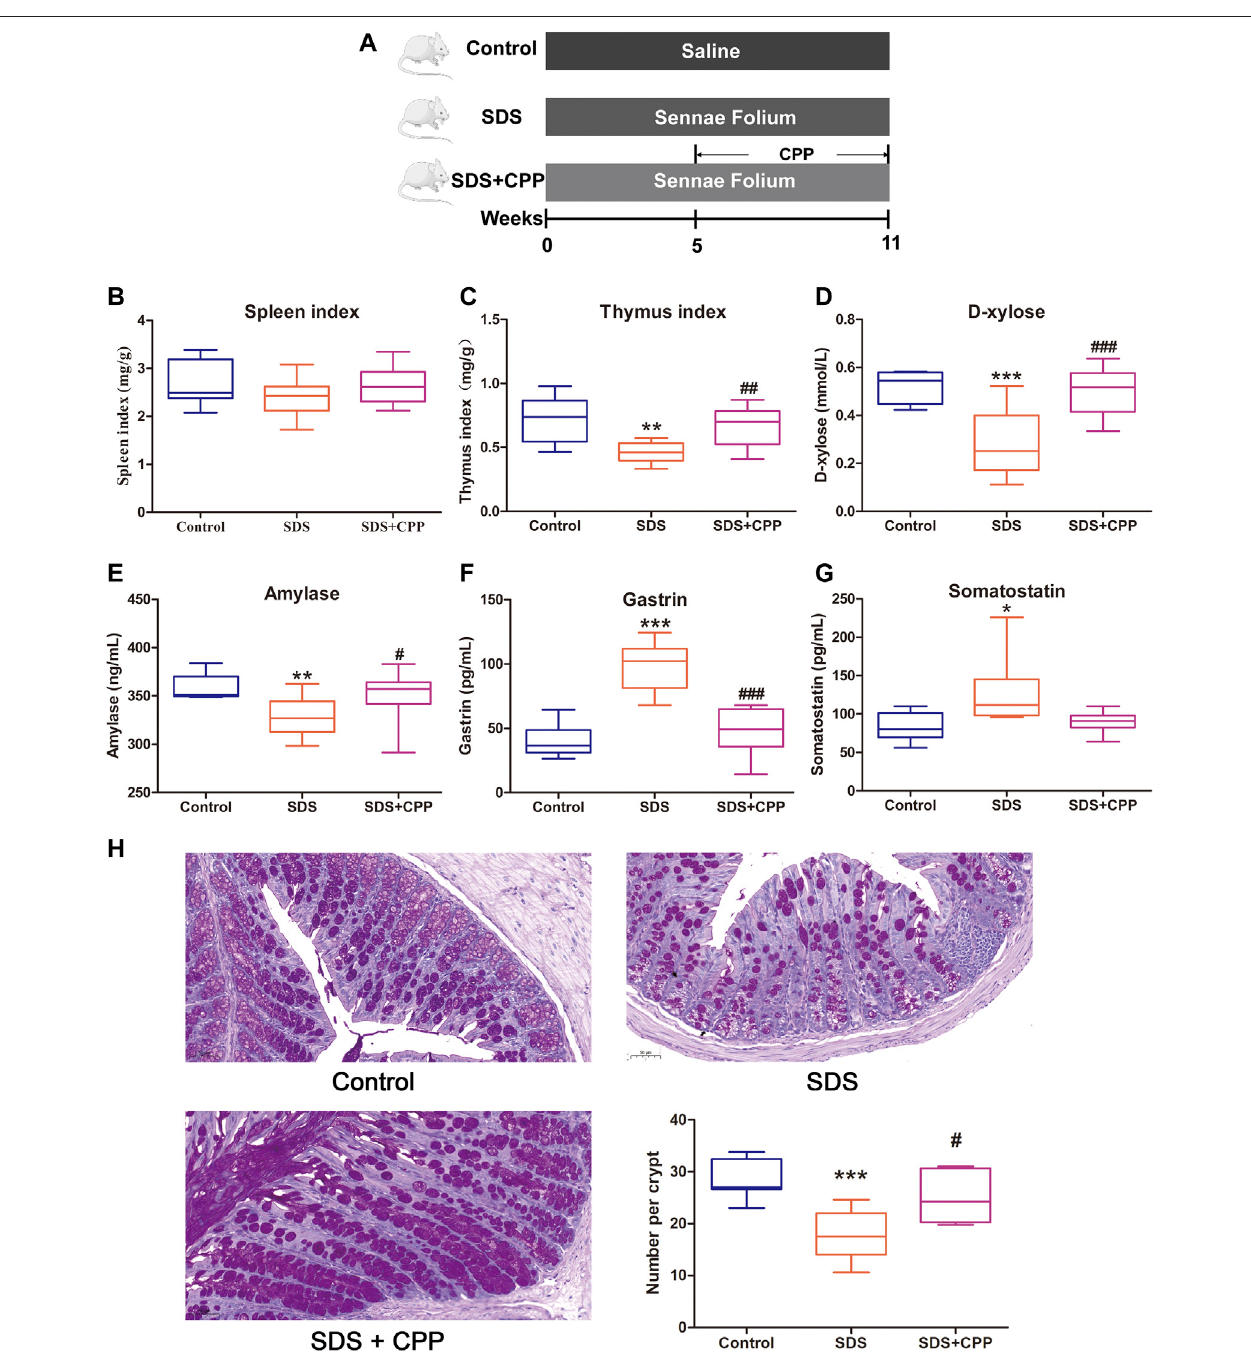
FIGURE 1 | CPP mitigated Sennae Folium-induced SDS. Boxplots provide range, mean, minimum and maximum value. (A) Timeline of experimental process of miceineachgroup. (B) EffectofCPPonspleenindex. (C) Changesinthymusindex. (D) Serumconcentrationof D -xylose. (E) Serumlevelsofamylasere fl ectingdigestive ability. (F) Serum concentration of GAS. (G) Serum concentration of SS. (H) Representative PAS-stained colonic sections (×200 magni fi cation) in each group; and number of goblet cells per crypt in each group. Data were expressed as mean ± SEM ( n = 8 – 10). * p < 0.05, ** p < 0.01, *** p < 0.001 vs. control group; # p < 0.05, ## p < 0.01, ### p < 0.001 vs. SDS group. SDS: spleen de fi ciency syndrome group. SDS + CPP: spleen de fi ciency syndrome + Codonopsis pilosula polysaccharide treatment group.